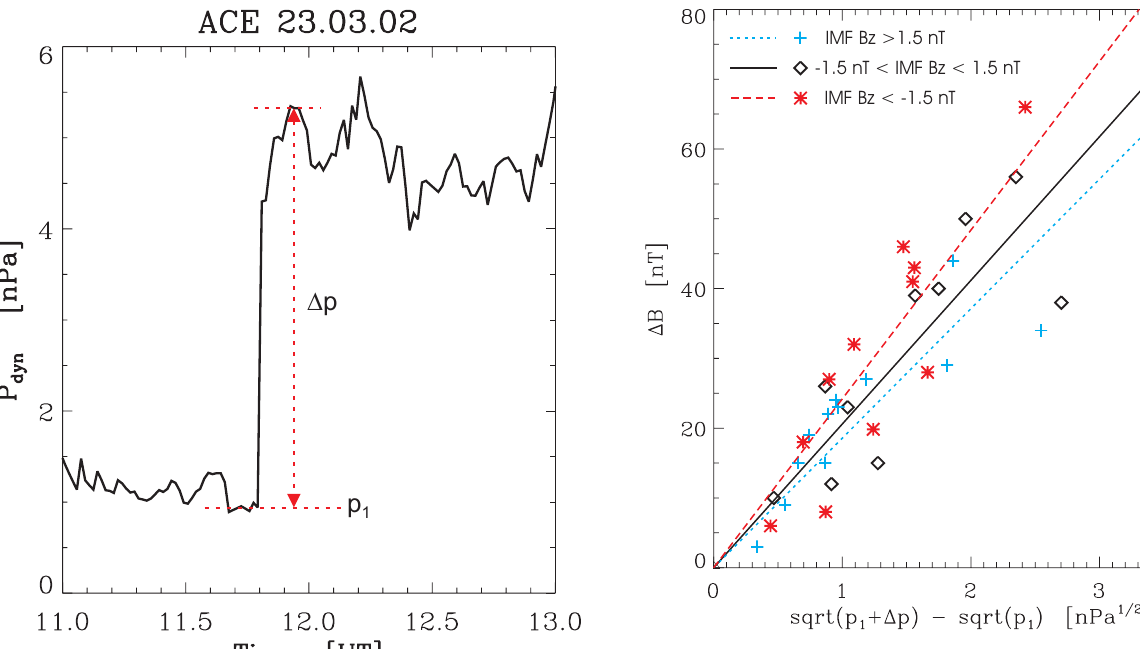
Fig. 8. Amplitude of the SCs (from CHAMP data) as a function of the step in the square root of the solar wind dynamic pressure (from ACE data, see Eq. (7), The events are sorted according to three different ranges of the interplanetary magnetic field, B z . The corresponding lines are best fits to the three different data